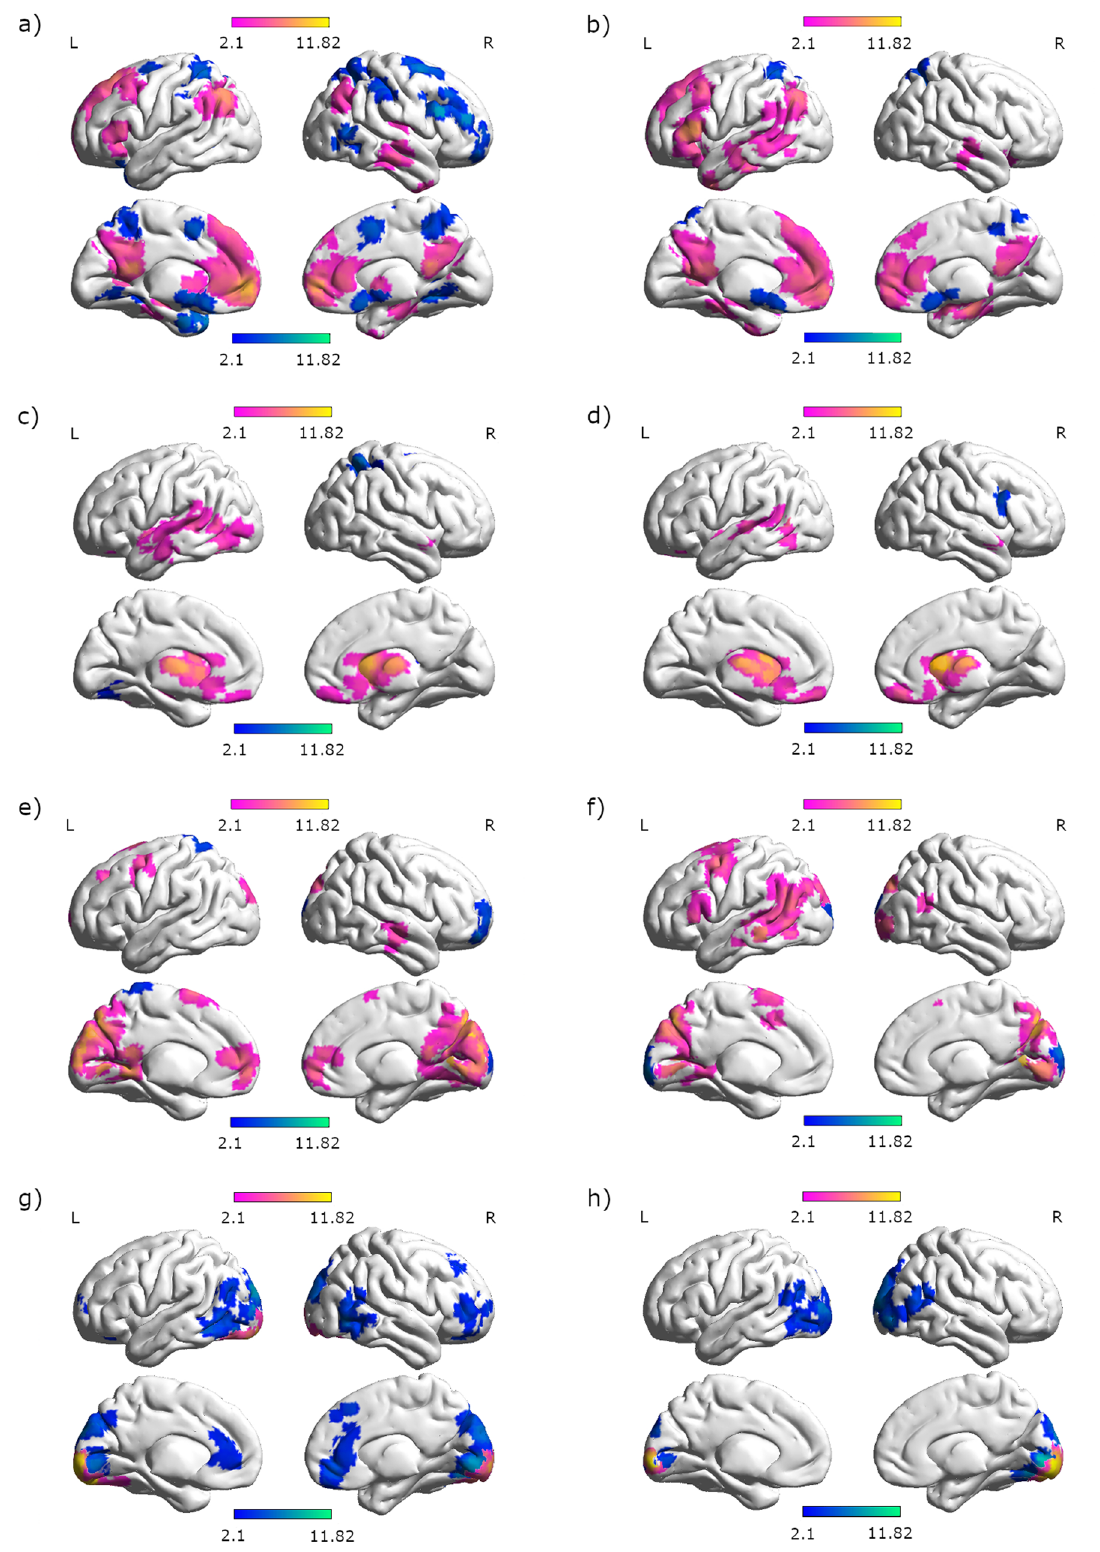
Fig. 6 Areas with differential connectivity between men and women. Areas with stronger connectivity for women compared to men are displayed in pink. Areas with stronger connectivity for men compared to women are displayed in blue. Seed regions: a left hippocampus, b right hippocampus, c left caudate, d right caudate, e left retrosplenial cortex, f right retrosplenial cortex, g left primary visual cortex, h right primary visual